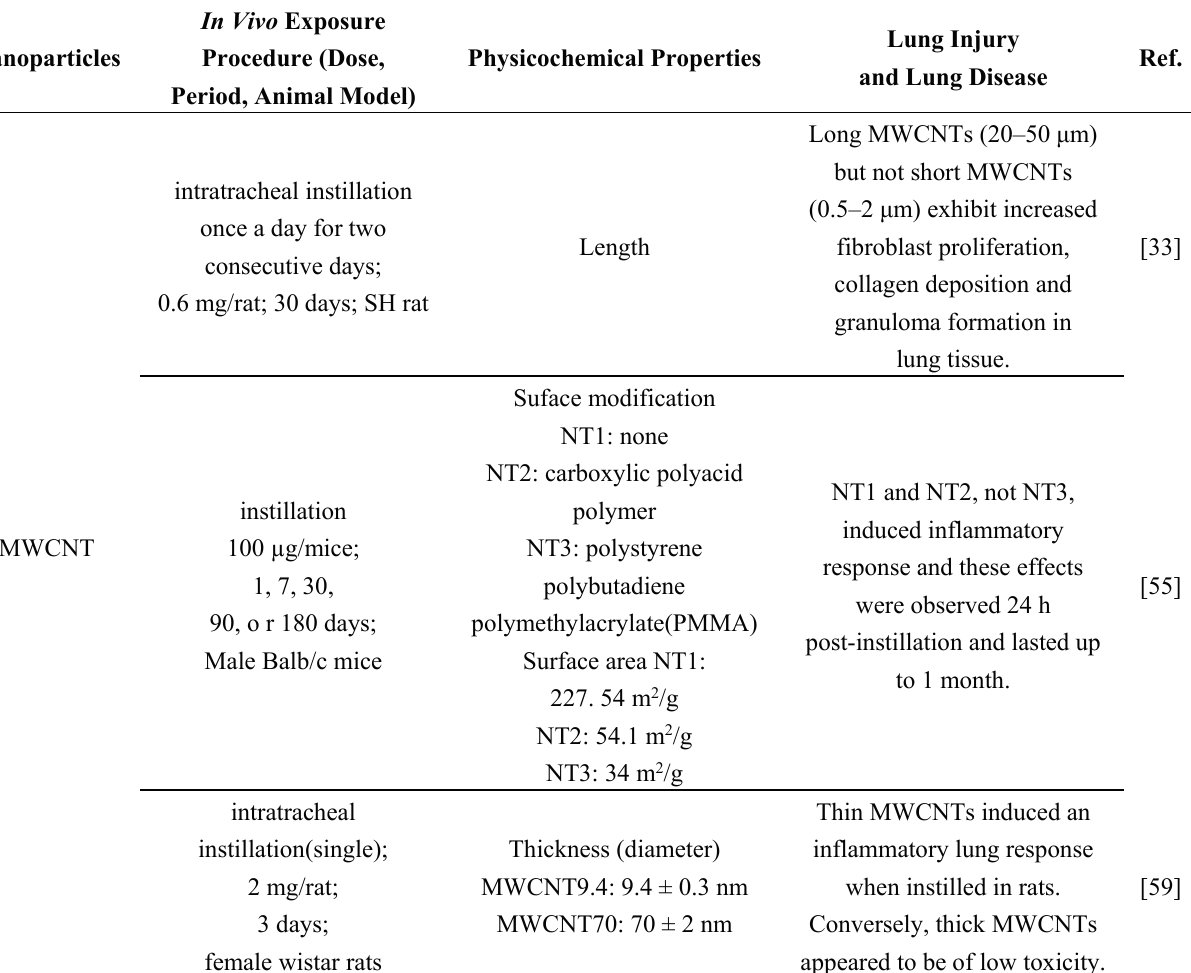
Table 2. Physicochemical properties of inhaled NPs are critial factor to cause pathobiological processes.